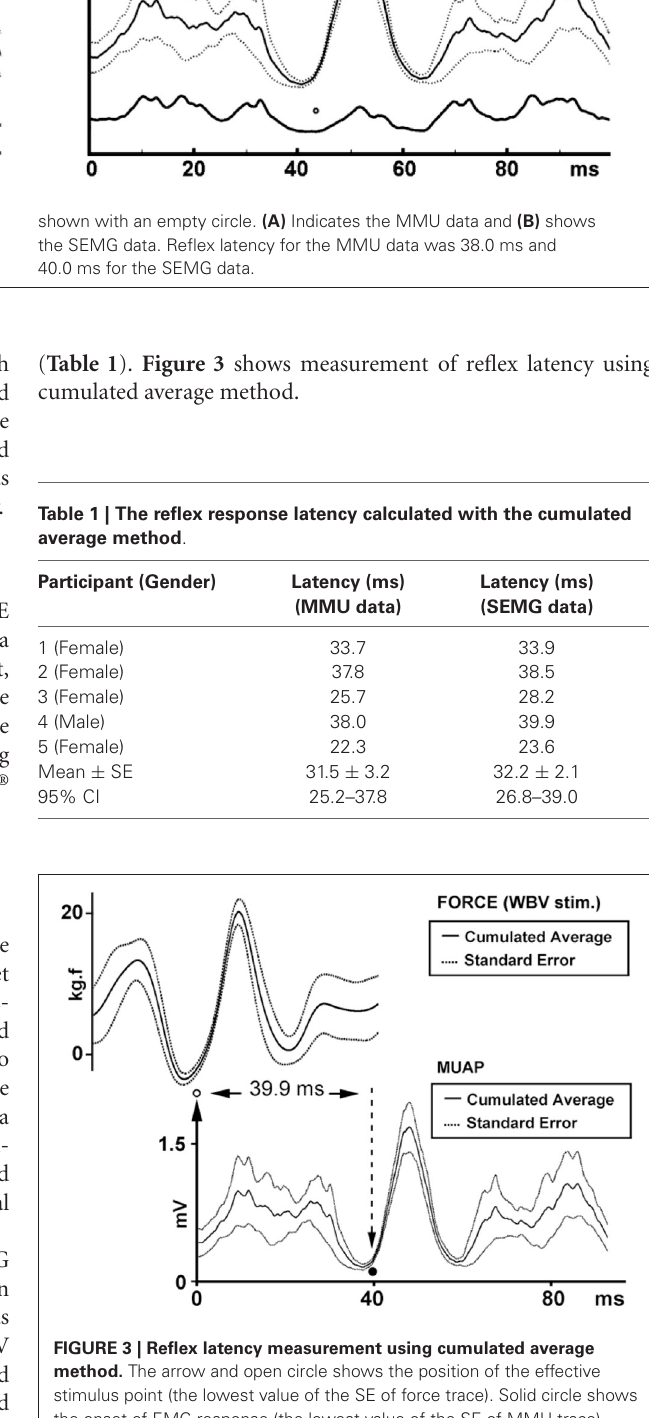
FIGURE 2 | Cumulated average MMU and SEMG where the local minimum of the force trace was used as the trigger . Reflex latency was indicated by the lowest SE on the cumulative averaged data and